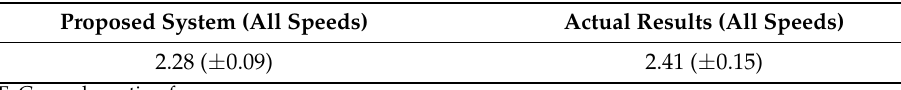
Table 2. GRF peak force metric evaluation: measured and predicted. Proposed System (All Speeds)